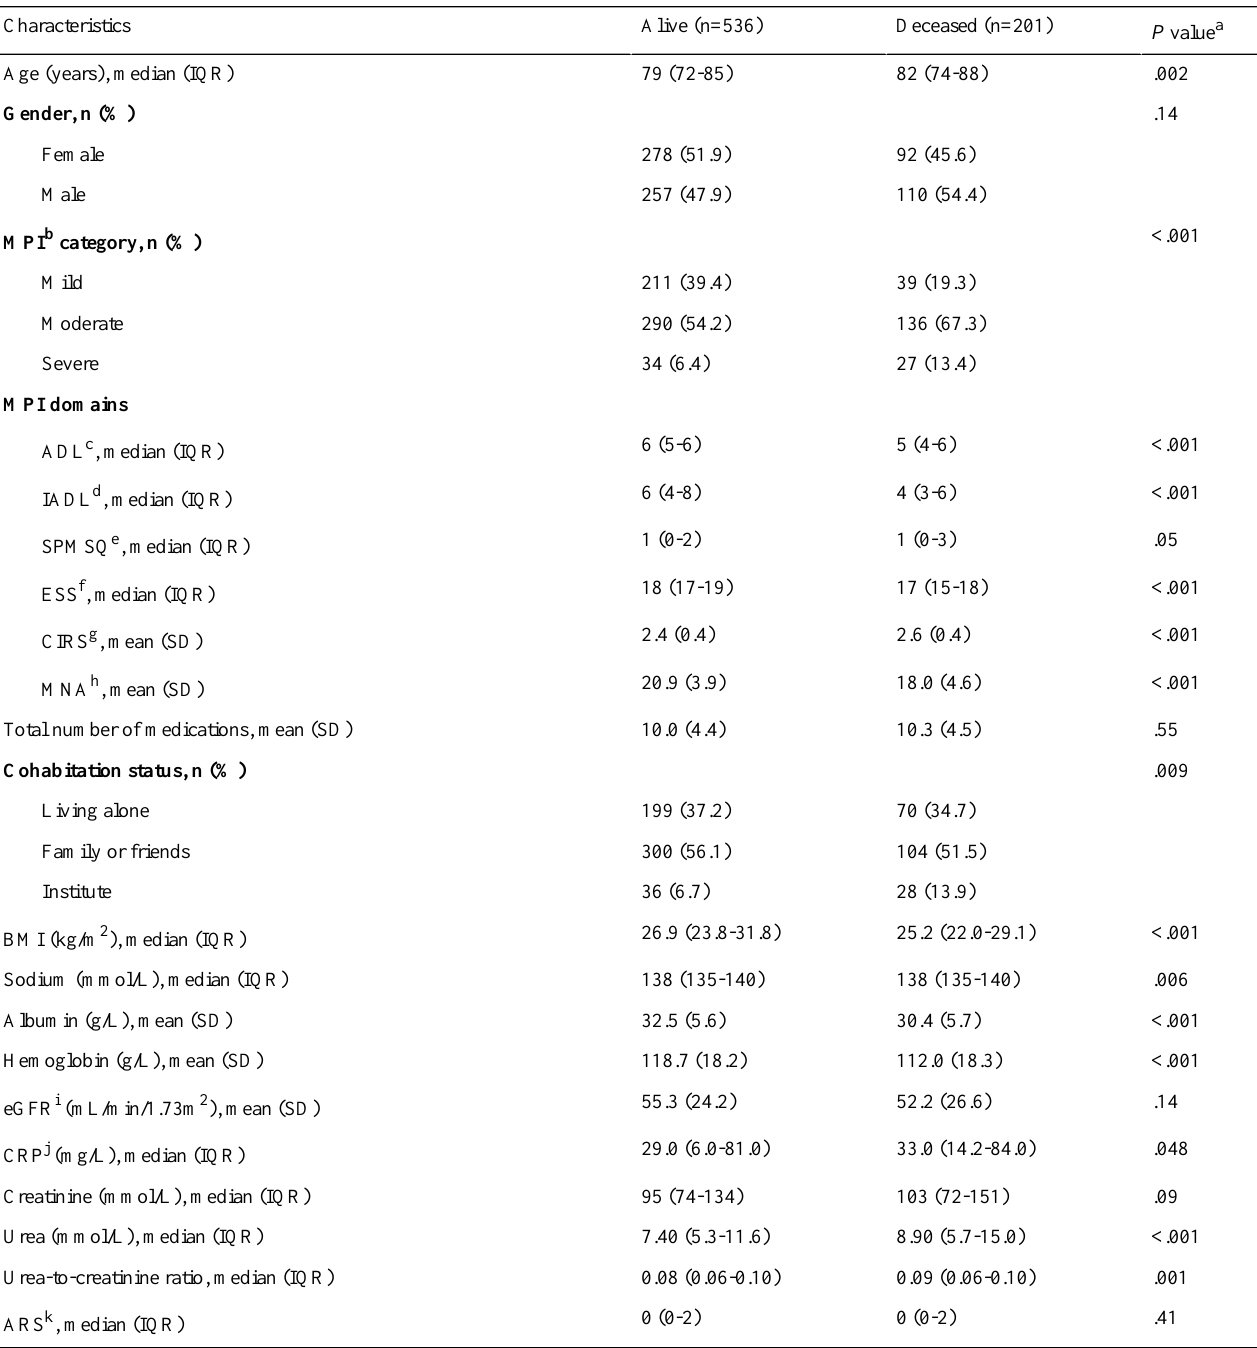
Table 1. Patient characteristics according to vital status at 12 months after hospital discharge.